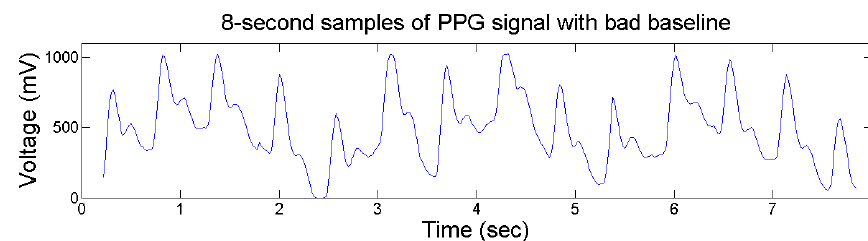
Figure 4. Typical plots of PPG signal with bad baseline.